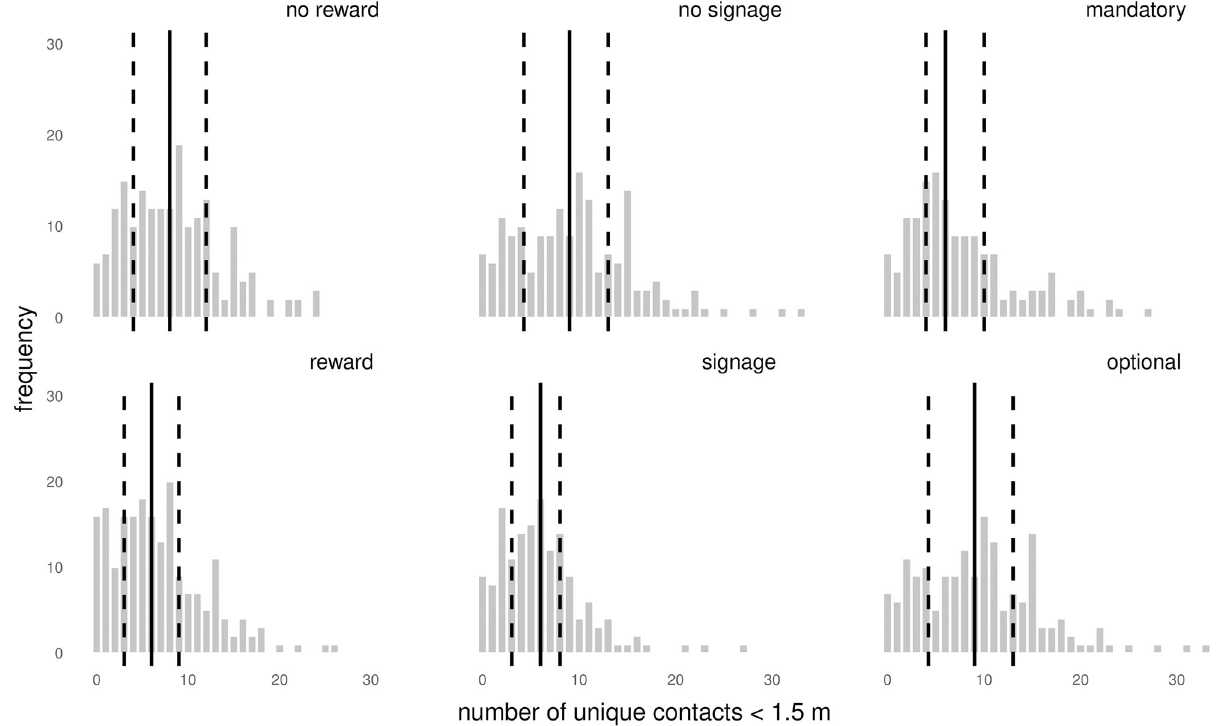
Fig 3. Contacts per experimental condition. The number of unique contacts ( < 1.5 m) in each of the six conditions. The solid line represents the median, and the two dashed lines the 25 th and 75 th percentiles, such that 50% of the observations fall within the two dashed lines.